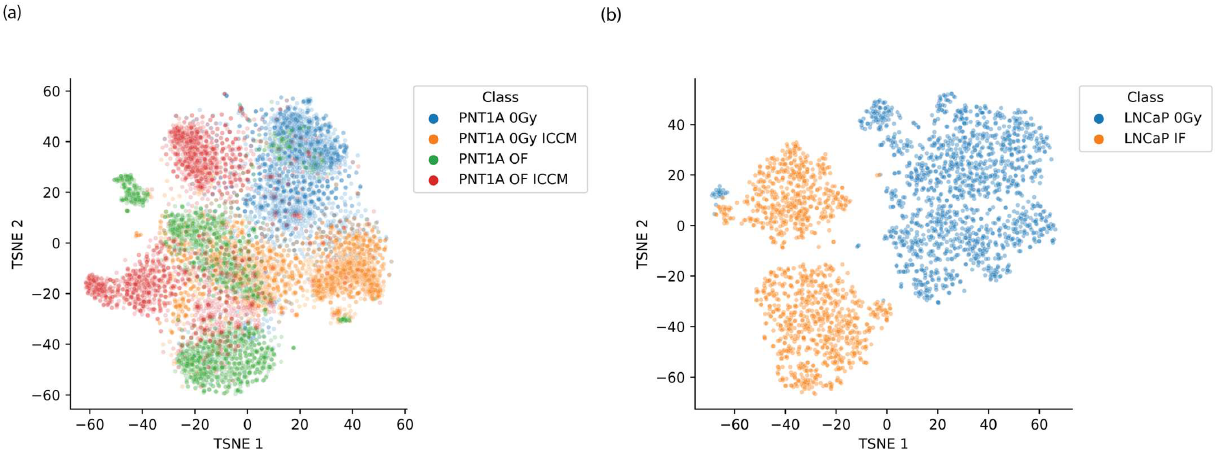
Figure 3. Representative t-SNE scores plots for ( a ) PNT1A cells exposed to a range of treatment modes and ( b ) LNCaP cells exposed to 2Gy (IF) and 0Gy (Control).